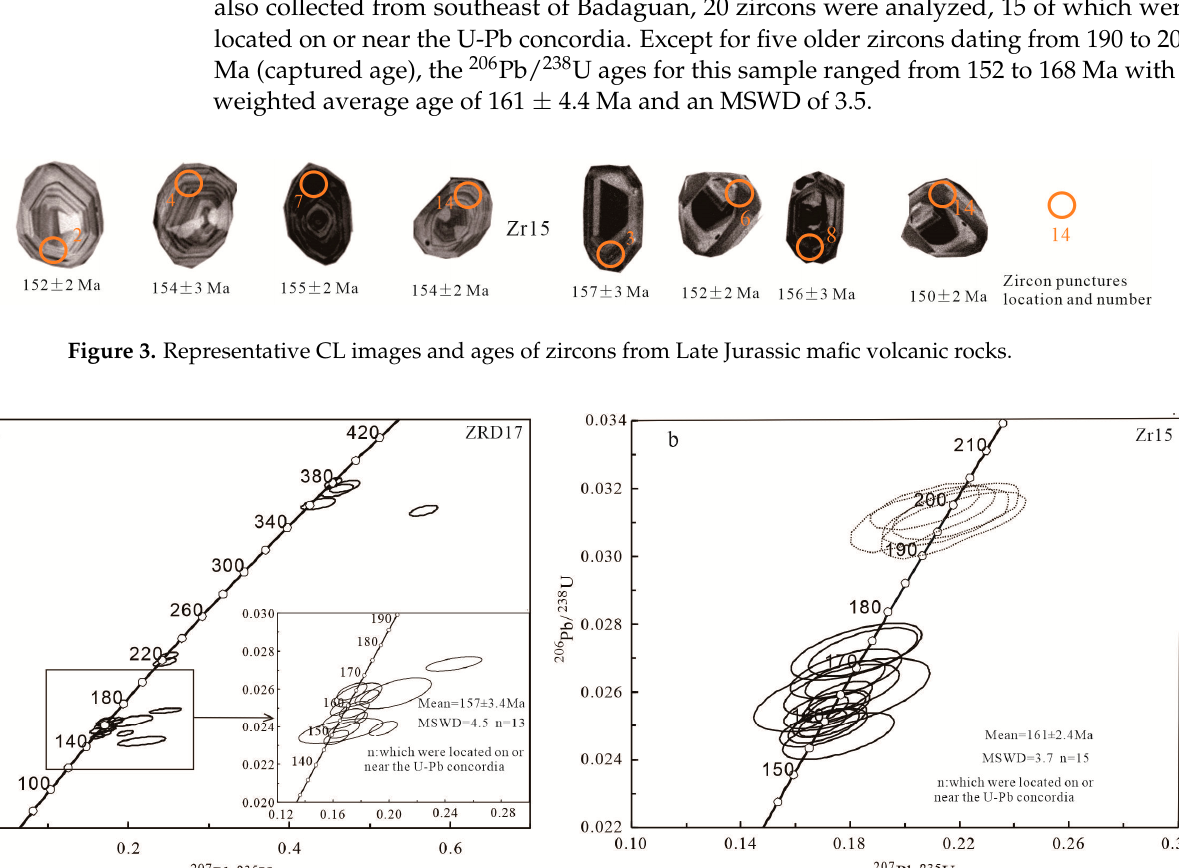
Figure 4. ( a ) sample ZRD17 ( b ) sample Zr15. Zircon U-Pb age concordia map of mafic volcanic rocks.